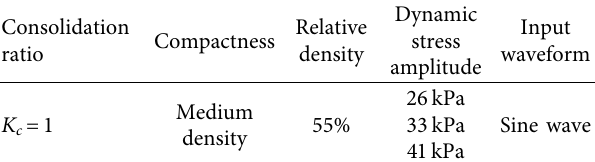
Table 3: The test scheme.